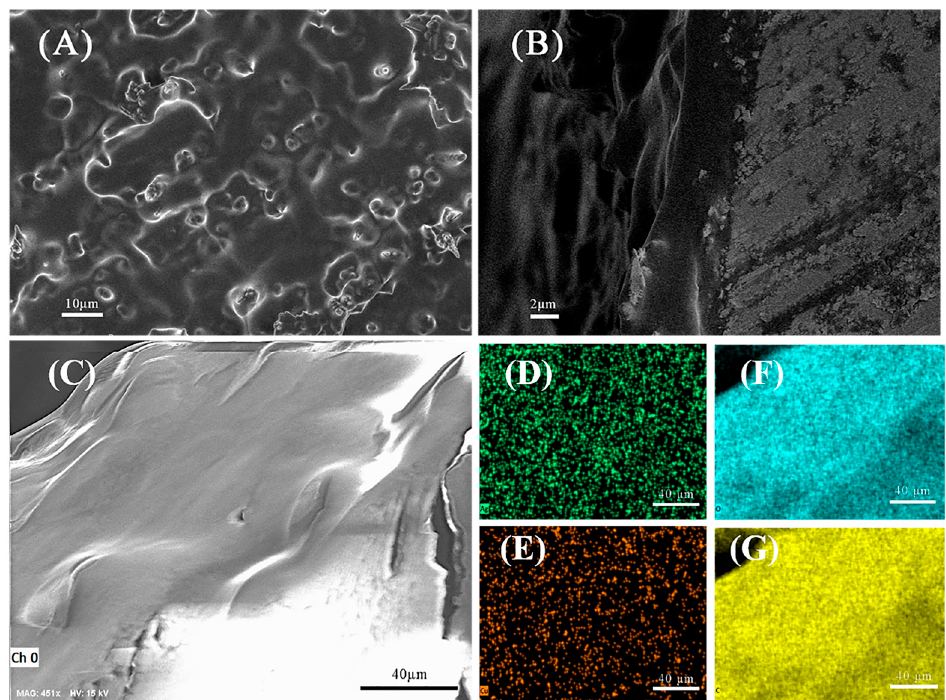
Figure 3. ( A ) Surface of Ag NPs–MIPs film. ( B ) Cross-section of Ag NPs–MIPs film. ( C ) EDX images of the surface and the composition of silver ( D ), copper ( E ), oxygen ( F ), and carbon ( G ) of the Ag NPs–MIPs films.